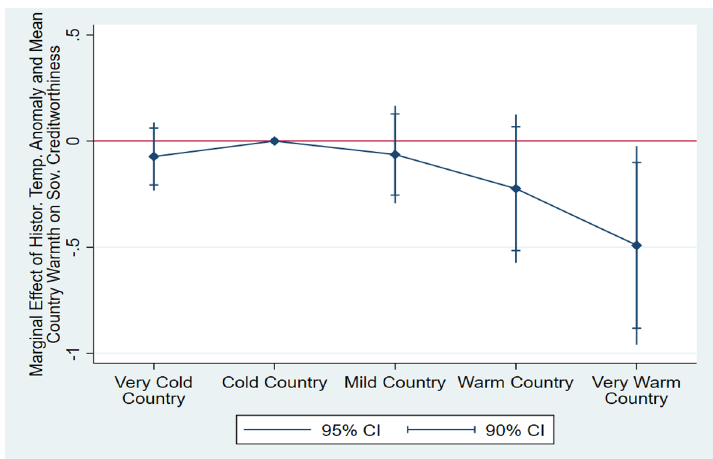
Fig. 4 Coefficients estimated in Table 7 for climatic bins according to percentiles of average